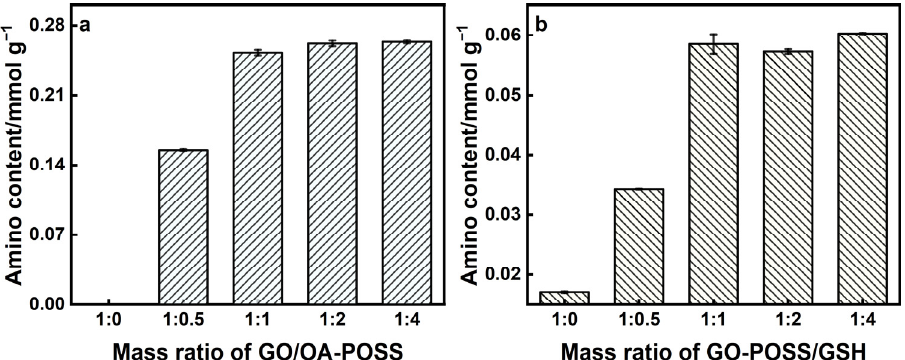
Figure 1. ( a ) Amino group contents on GO–POSS obtained with different GO/OA–POSS mass ratios. ( b ) Amino group contents on GPG composite obtained with different GO–POSS/GSH mass ratios.